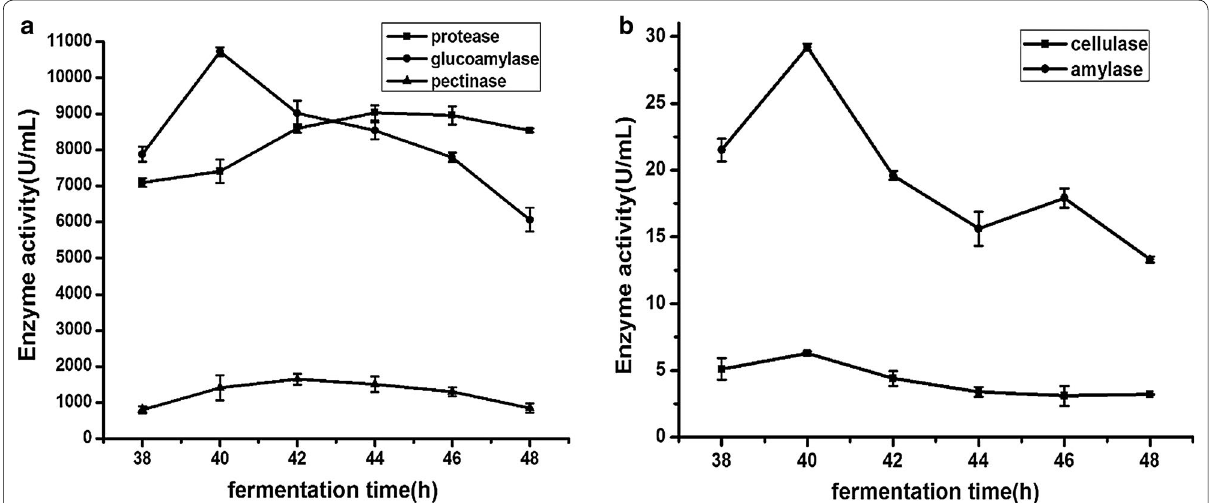
Fig. 2 The relationship between fermentation time and exoenzyme activity in a and b . The proteinase, glucoamylase and pectase are shown in a . Cellulase and amylase are shown in b . The activities of enzymes were sampled every 2 h when the cultivation time was between 38 and 48 h. Data are mean SD (n 3). The types and optimum fermentation times of the extracellular enzymes were ± =